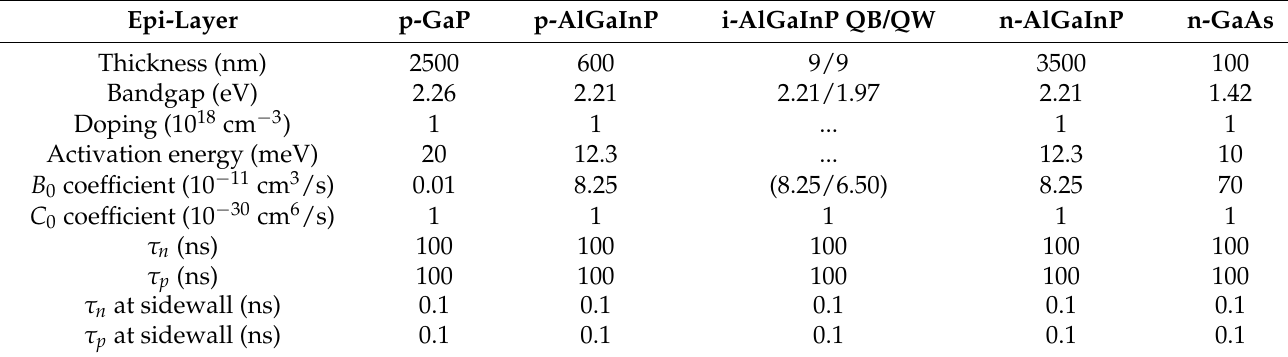
Table 2. Parameters of red µ